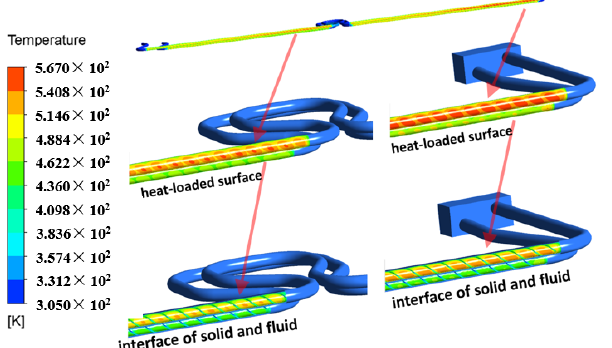
Figure 11. Temperature field when the swirl tape’s length is the same as the heat-loaded surface’s length.